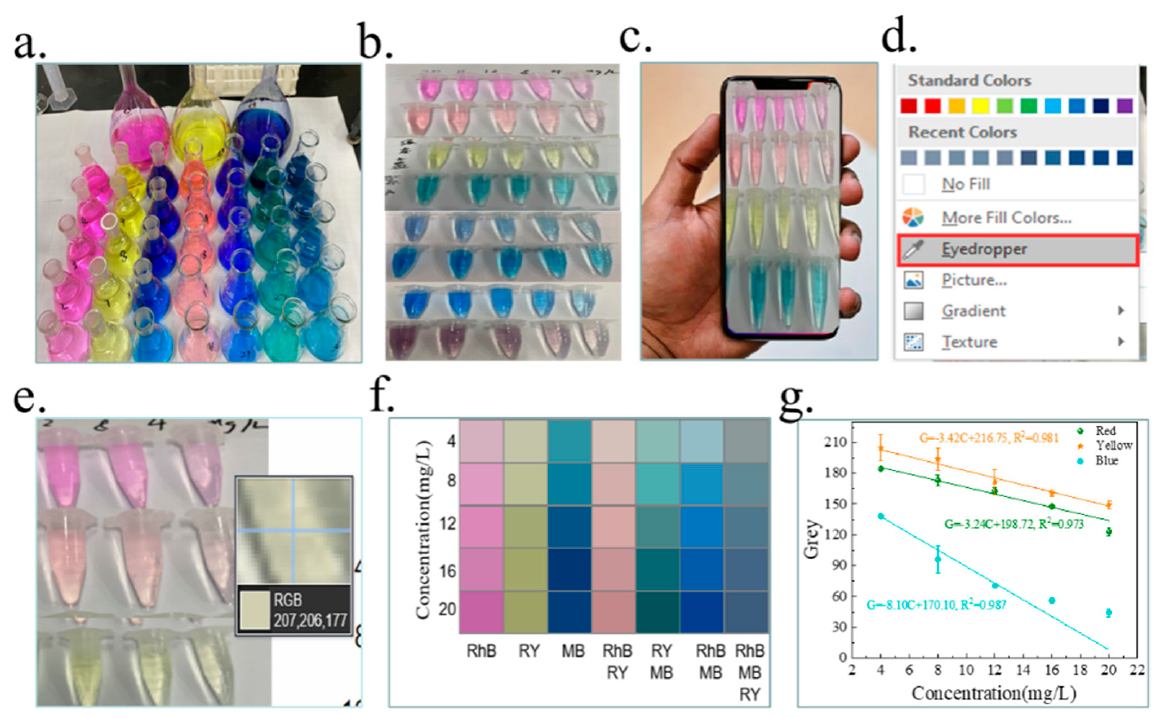
Scheme 1. A flow chart of the PMTs method for measuring the greyscale-concentration standard curve: ( a ) Different color dye wastewaters configuration based on the pigment trichromatic theory and diluted to different concentrations; ( b ) sampling wastewater into 1.5 mL centrifuge tubes and placing the tubes in the background of clean A4 white paper; ( c ) taking photos using the original camera of the smartphone; ( d ) importing the photos into WPS PowerPoint and using the eyedropper for multi-point sampling; ( e ) reading the RGB color values in the middle of the centrifuge tube and taking multiple samples to obtain the average; ( f ) the sample colors were recorded with rectangular color blocks in WPS PowerPoint; ( g ) the greyscale values calculated from the RGB data were imported into the Origin graphing software to obtain the standard curve fitting formula.